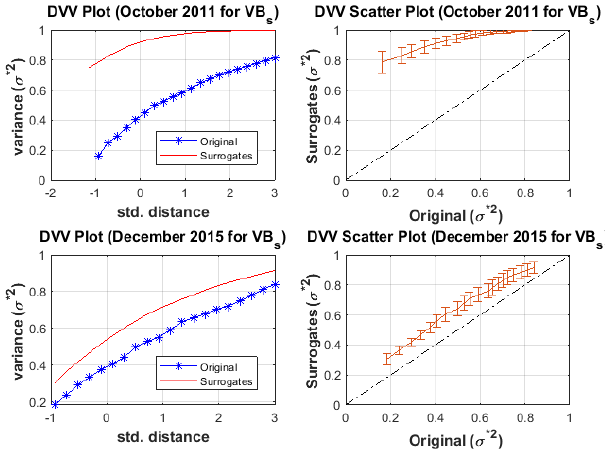
Figure 12. The DVV plot and scatter plot for VB s during major geomagnetic storm for October 2011 and December